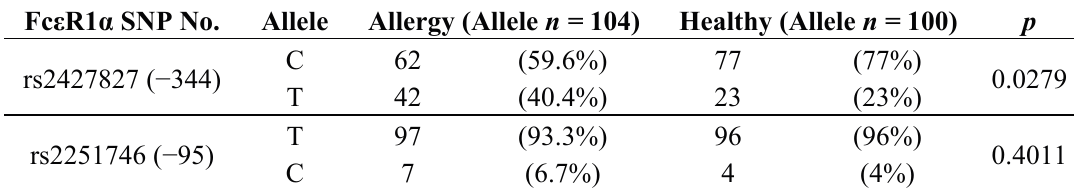
p for Chi-square test. Table 3. Allele frequency Difference of Fc ε R1 α promoter region between allergic and normal